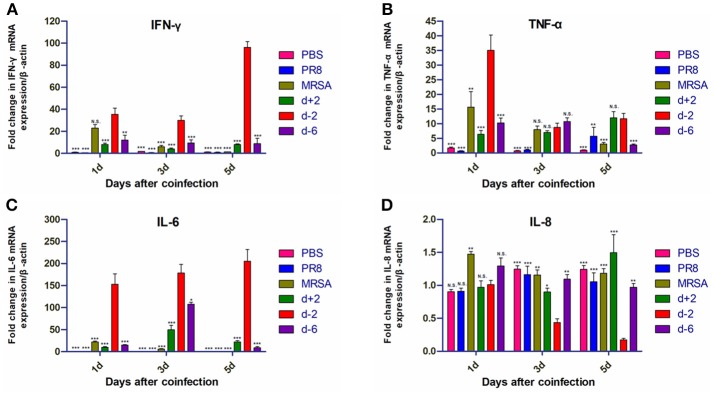
Inflammatory cytokine mRNA levels in mice coinfected with influenza virus and methicillin-resistant S. aureus. mRNA levels of (A) IFN-γ, (B) TNF-α, (C) IL-6, and (D) IL-8 in the lung tissues of coinfected mice according to different infection sequences and times. For multiple comparisons, we used one-way analysis of variance with the Tukey post hoc test. Data are represented as mean ± standard error of the mean. (N.S., not significant; *p < 0.05; **p < 0.01; ***p < 0.001, n = 6). PR8, influenza A virus strain; MRSA, methicillin-resistant S. aureus; PBS, phosphate-buffered saline. IFN, interferon; TNF, tumor necrosis factor; IL, interleukin.